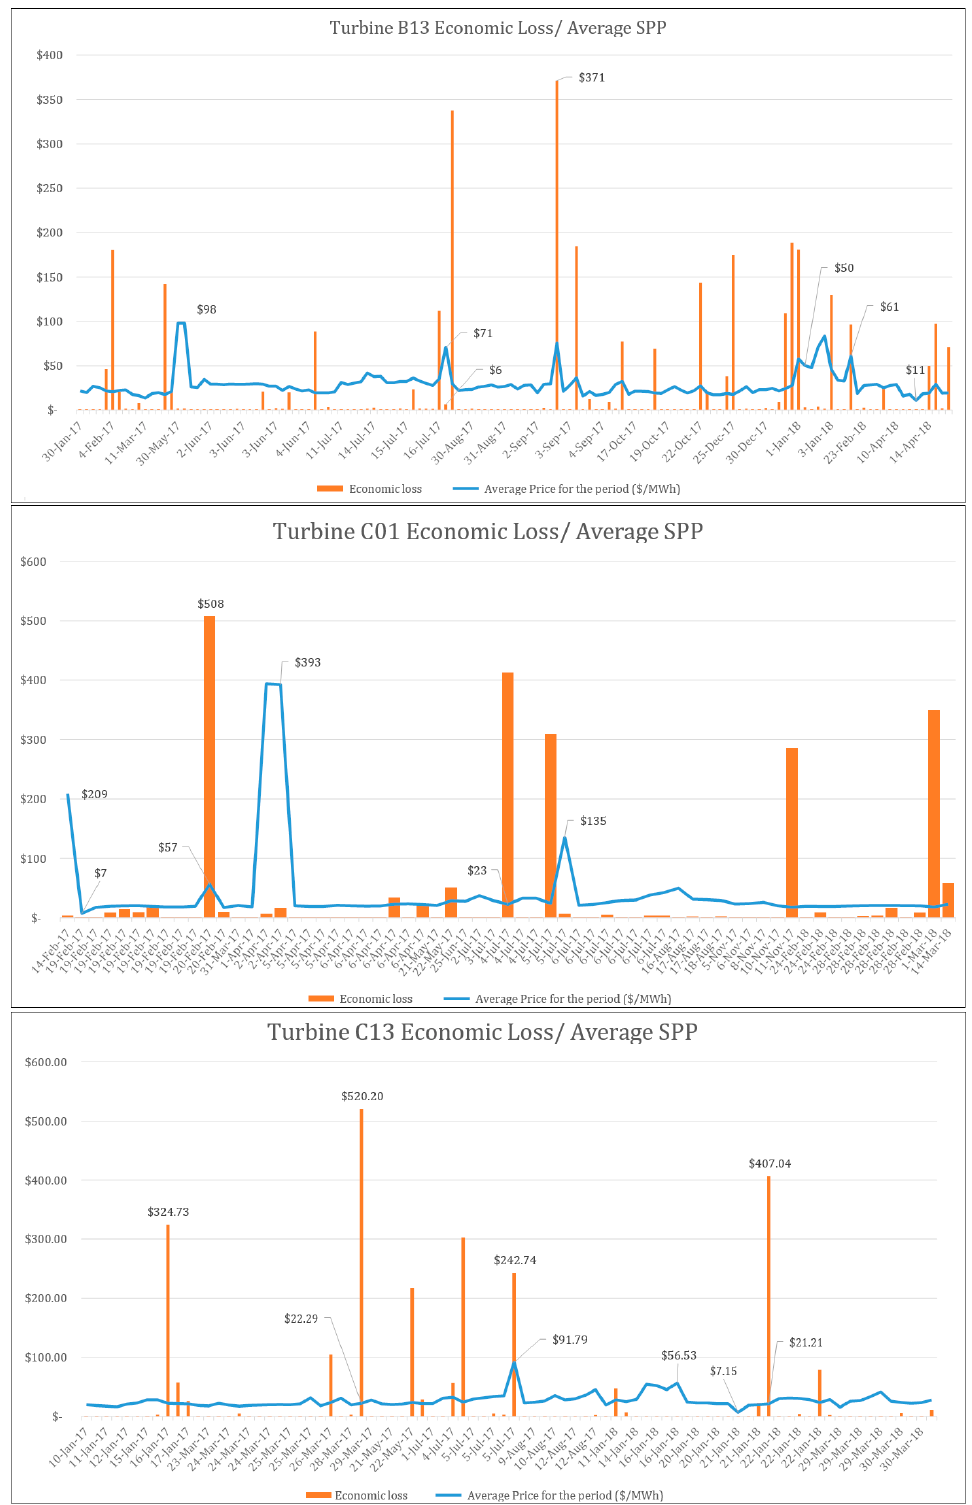
Figure 5. Economic loss/average SPP—Wind Turbines (B13), (C01), and (C13).